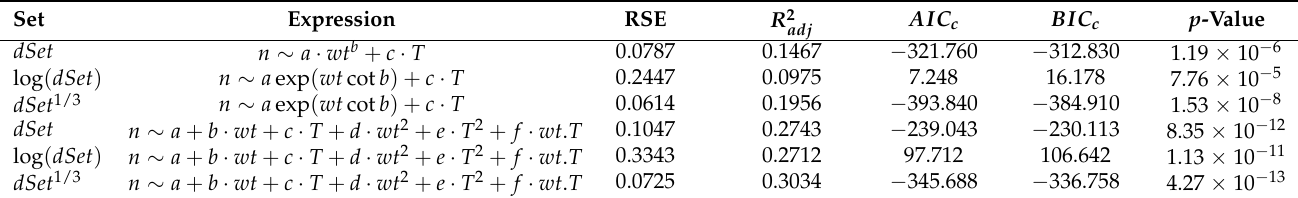
Table 17. Regression results for n as a function of wt and T for the AS